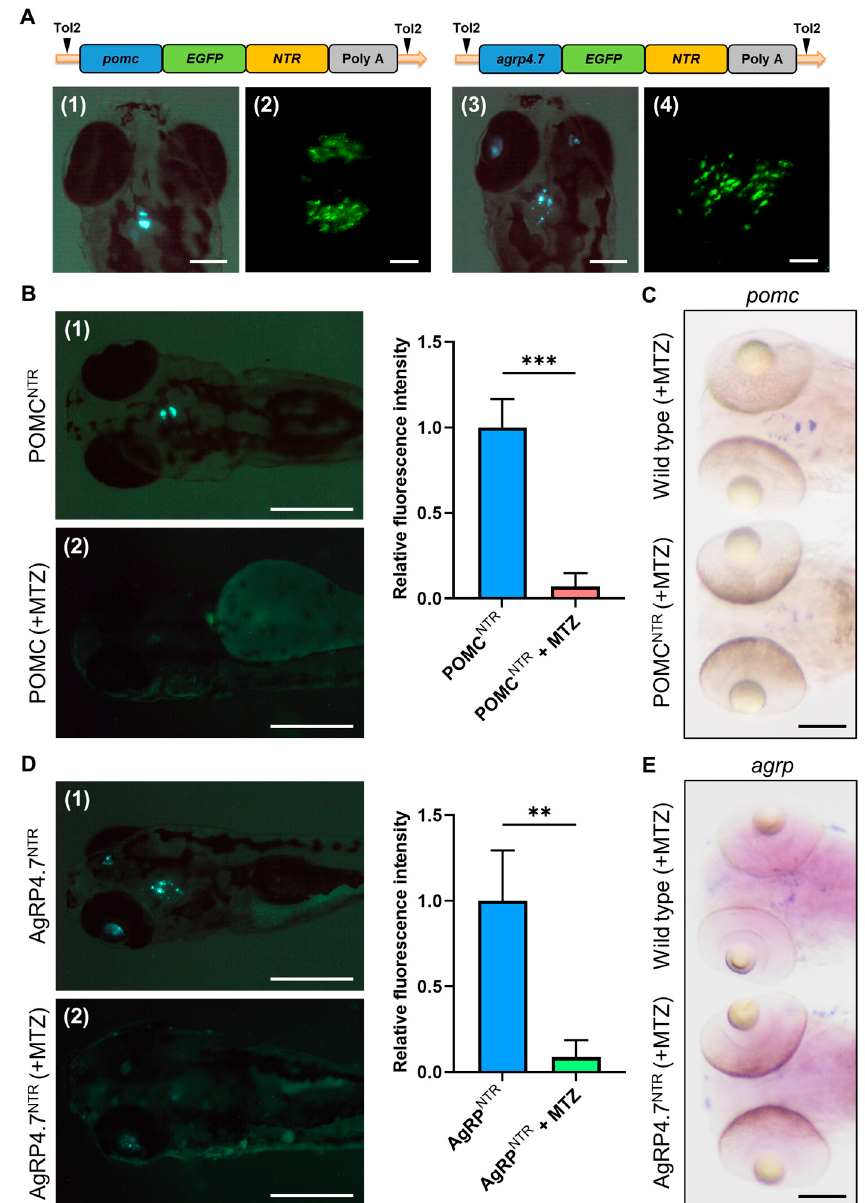
Figure 2. Establishment of POMC NTR and AgRP4.7 NTR transgenic fish and neuron ablation tests. ( A ) Schematic diagram of the DNA construct used to generate POMC NTR and AgRP4.7 NTR transgenic zebrafish lines. Fluorescence images of ( 1 ) POMC NTR and ( 3 ) AgRP4.7 NTR larval head at 5 days post-fertilization (dpf) (Scale bar: 200 µ m). Confocal images of ( 2 ) pro-opiomelanocortin (POMC) neurons of POMC NTR and ( 4 ) AgRP neurons of AgRP4.7 NTR at 5 dpf (Scale bar: 20 µ m). ( B ) Left: Fluorescence images of ( 1 ) POMC NTR transgenic zebrafish larvae at 5 dpf and ( 2 ) metronidazole (MTZ)-treated POMC NTR transgenic zebrafish larvae at 5 dpf, n = 3. Scale bar: 500 µ m. Right: quantification diagram of fluorescence intensity. All values are the mean ± standard error of the mean (SEM), n = 30. *** p < 0.001. ( C ) Whole mount in situ hybridization (WISH) assays showing the expression signals of pomc transcripts in POMC neurons in wild-type (WT) and POMC NTR larvae at 5 dpf, n = 30. Scale bar: 100 µ m. ( D ) Left: Fluorescence images of ( 1 ) AgRP4.7 NTR transgenic zebrafish larvae at 5 dpf and ( 2 ) MTZ-treated AgRP4.7 NTR transgenic zebrafish larvae at 5 dpf, n = 3. Scale bar: 500 µ m. Right: quantification diagram of fluorescence intensity. All values reported as mean ± SEM, n = 30. ** p < 0.01. ( E ) WISH assay results showing the expression signals of agrp transcripts in AgRP neurons in WT and AgRP4.7 NTR larvae at 5 dpf. Scale bar: 100 µ